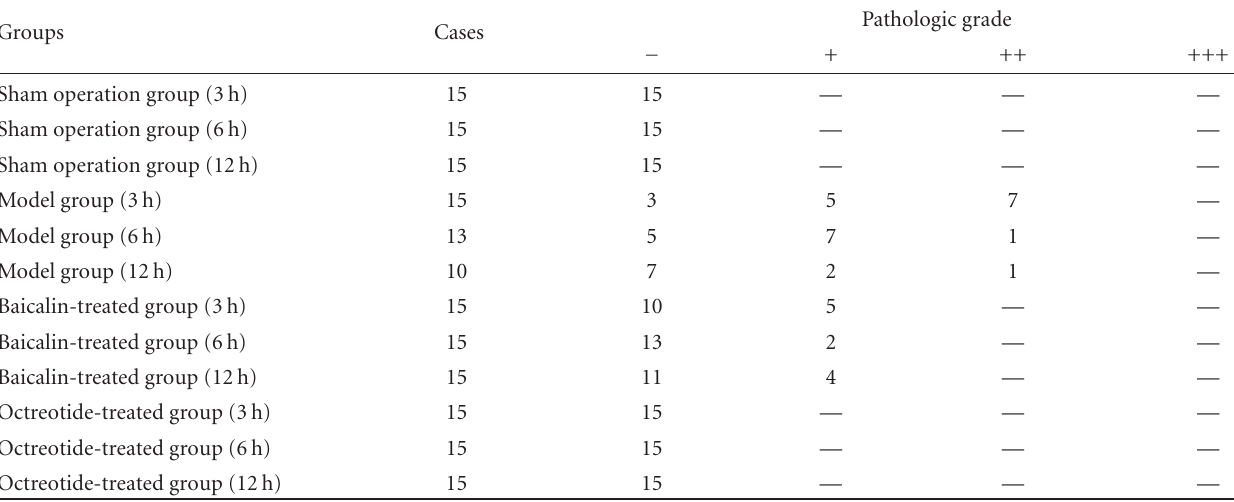
Table 3: Changes of P-selectin protein expression in all groups.